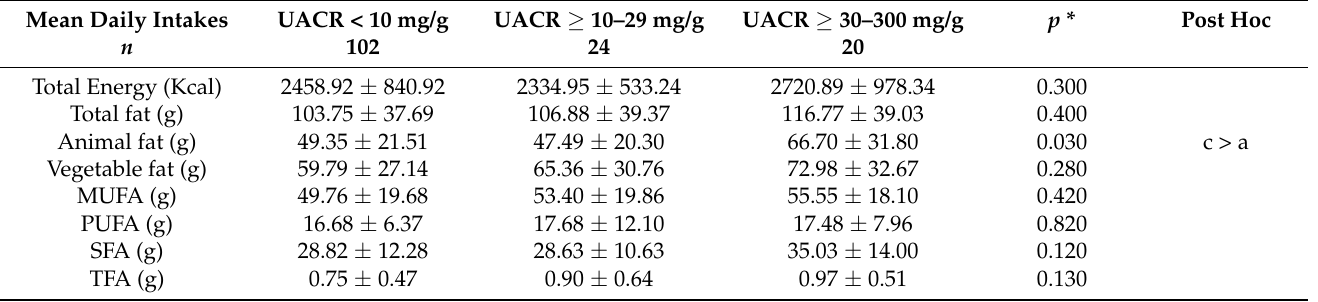
Table 2. Difference in fat intakes across stages of UACR.